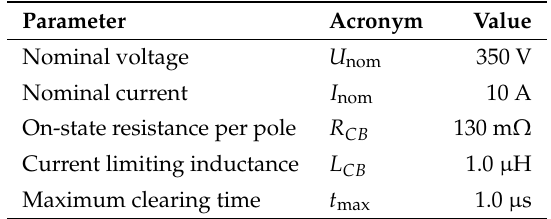
Figure 6. Base design of the solid-state circuit breakers that are used in this paper. Table 1. Design parameters of the solid-state circuit breaker.